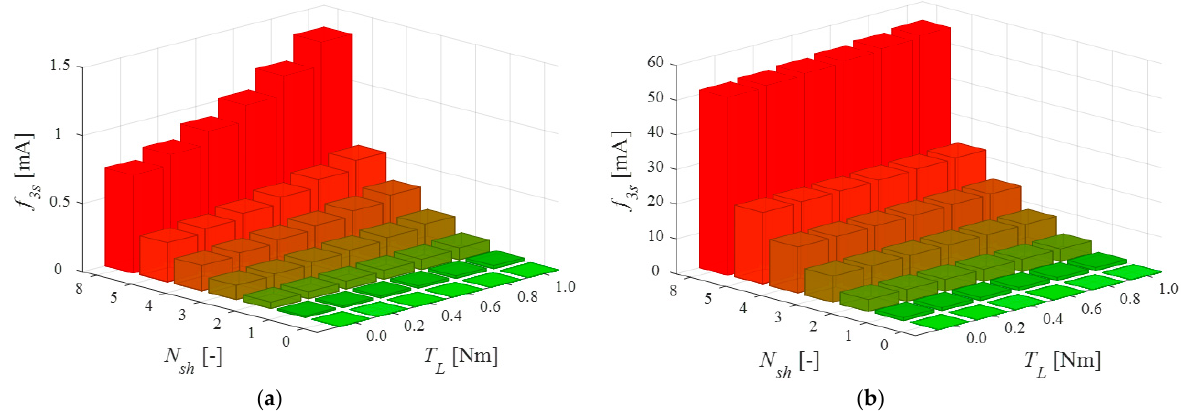
Figure 12. Dependence of the 3rd harmonic of the stator current amplitude, 3 f s , on the number of shorted turns and the load torque values for f s = 100 Hz: scalar control ( a ), field-oriented control ( b ).